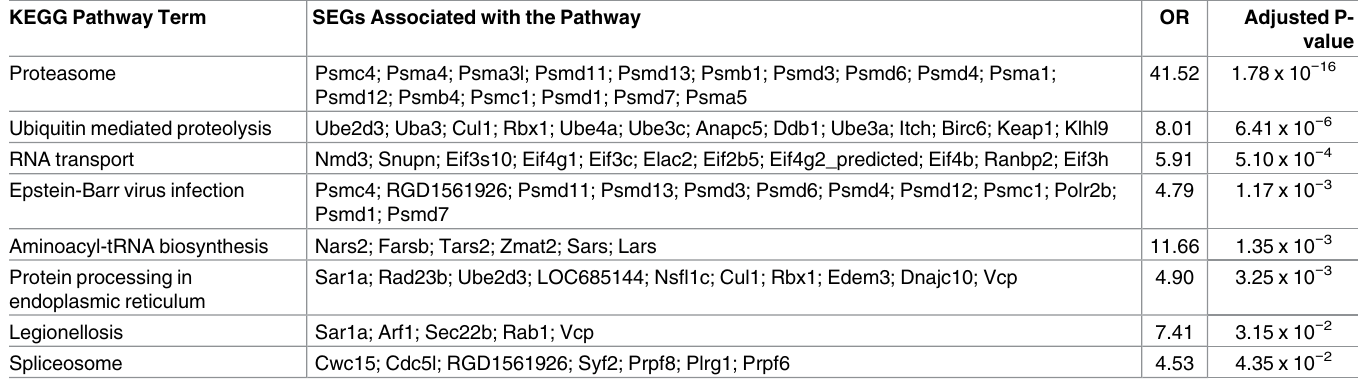
Table 1. KEGG pathways significantly enriched in SEGs.